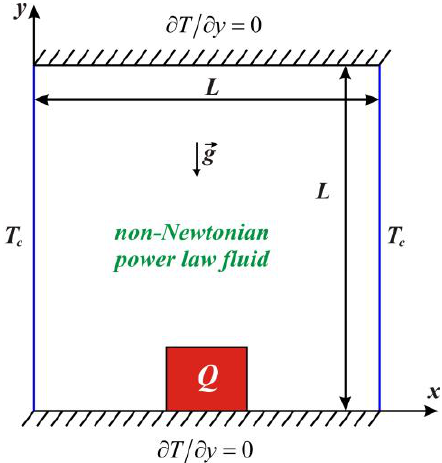
Figure 1. A schematic of the system.